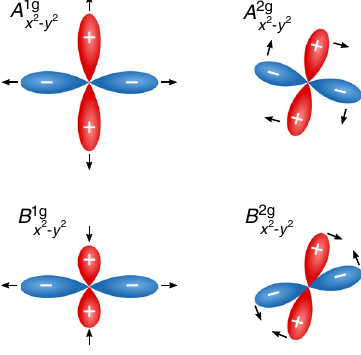
Fig. 2 Illustration of d - wave condensate oscillation symmetries . Possible condensate oscillation symmetries for a d -wave superconductor with x 2 (cid:1) y 2 point group symmetry D 4 of the underlying lattice. The arrows indicate the h motion of the lobes as a function of time. The notation of the gap symmetry in the subscript stresses the initial state, from which the oscillations of the condensate are